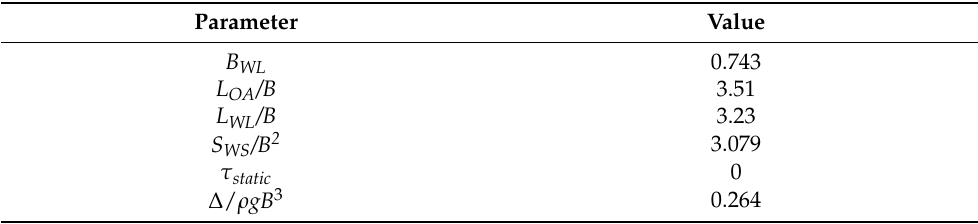
Figure 5. Body plan of model C1 [36]. Table 3. Principal characteristics of C1 model (all terms, expect the beam, are presented in non- dimensional form)